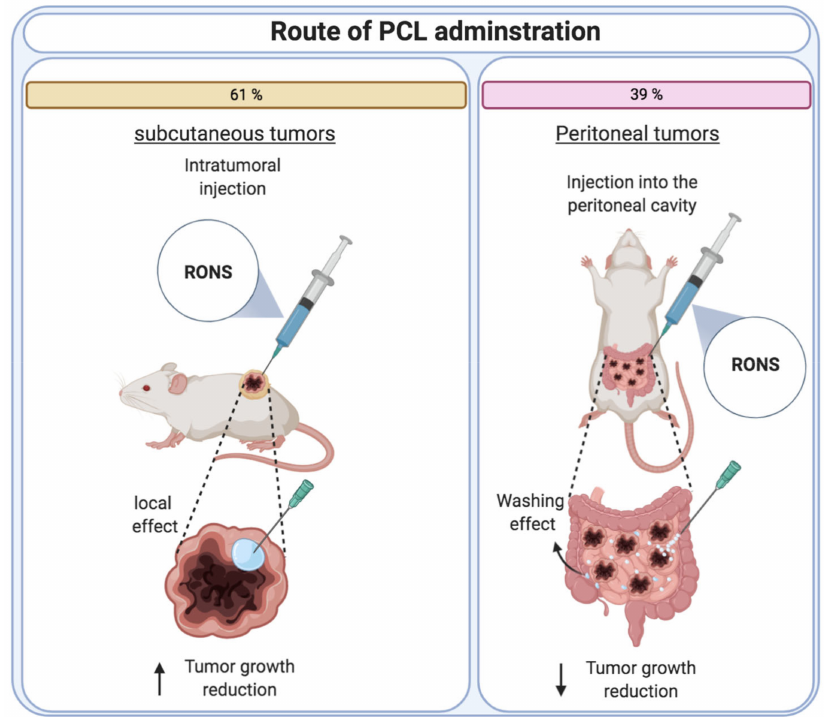
Figure 4. Schematic illustration of subcutaneous and peritoneal administration of PCL, including the percentage of the studies that used each route of administration to treat tumors in vivo with